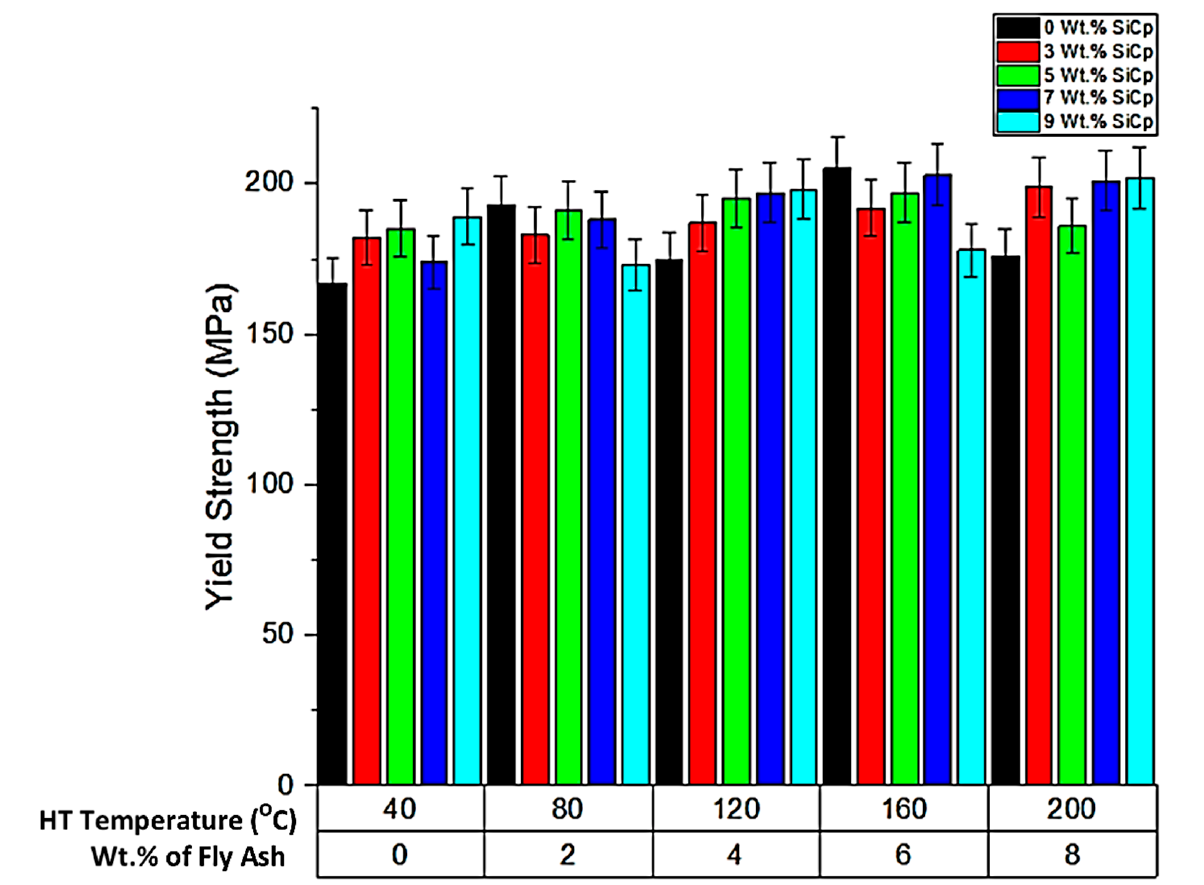
Figure 13. Yield strength for different experimental conditions.